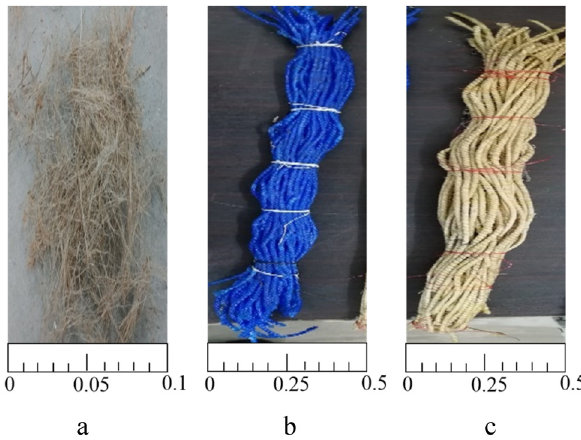
Figure 1: Fibers used: ( a ) coir fi ber, ( b ) polypropylene fi ber and ( c ) jute fi ber ( scale in meters ) .